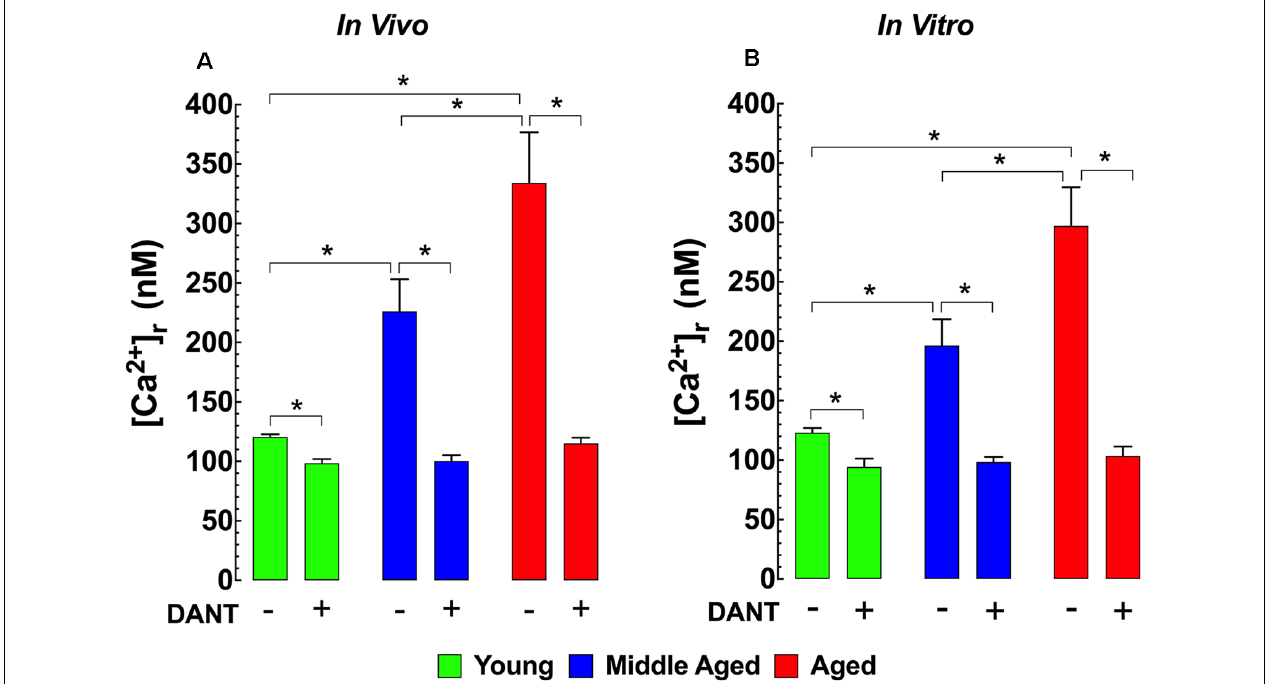
FIGURE 1 | Increased [Ca 2+ ] r in aged neurons. Effect of dantrolene. [Ca 2+ ] r was measured in quiescent young, middle-aged, and aged cortical neurons in vivo (A) and hippocampal pyramidal neurons in vitro (B) using double-barreled ion-specific microelectrodes. [Ca 2+ ] r was significantly higher in the middle-aged and aged than young neurons in both conditions. Dantrolene (2 mg/Kg IP) in vivo (A) or (20 µ M) in vitro (B) reduced [Ca 2+ ] r in all age-groups. The reduction of [Ca 2+ ] r greater in aged than young neurons. On the horizontal axis are indicated the experimental conditions used to measure [Ca 2+ ] r in vivo [Ca 2+ ] r measurements : n mice = 3–5/age group , n cell = 8–12/age group; in vitro [Ca 2+ ] r measurements: n mice = 4–5/ per age group , n cell = 11–17/age group. Values are expressed as means ± S.D. One-way ANOVA followed by Tukey’s post hoc comparisons, * p ≤